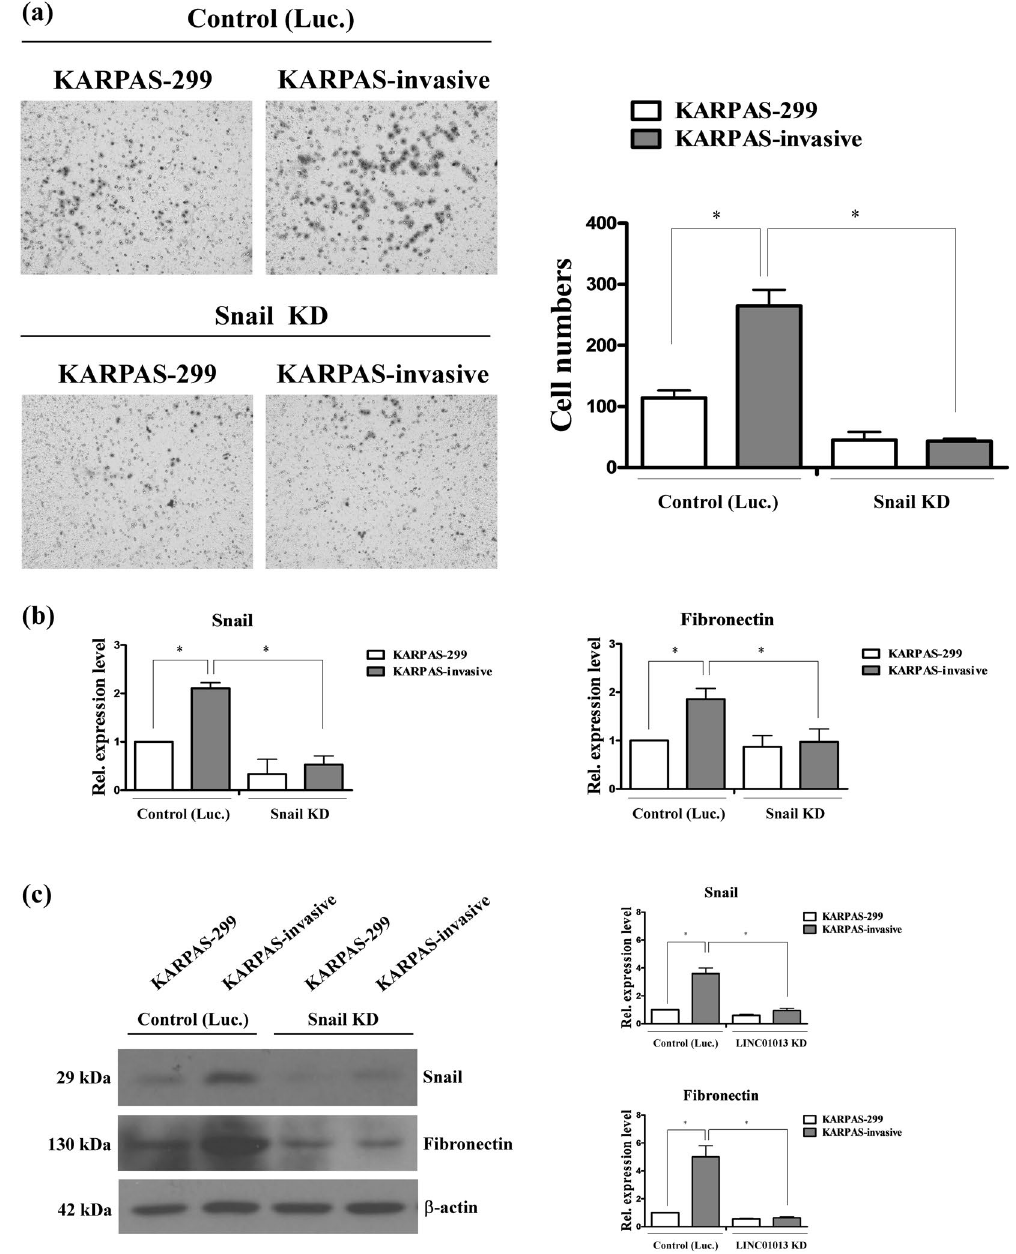
Figure 4. Snail depletion suppresses ALCL cell invasion. ( a ) Left panel : Invasion ability of KARPAS-299 and KARPAS-invasive cell lines was analyzed using Transwell assays under snail-depleted (Snail KD) and control (Luc.) conditions. Right panel : Quantification of invasion assay results. ( b ) Snail and fibronectin expression levels in these cell lines were determined by q-RT-PC ( c ) and Western blot analysis. Differences were analyzed using a Kruskal-Wallis test ( * P <